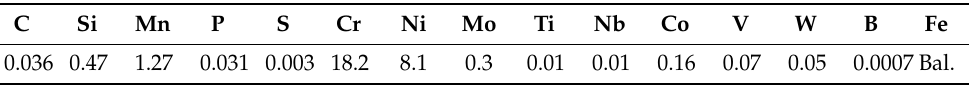
Table 1. Chemical composition of the used AISI 304 stainless